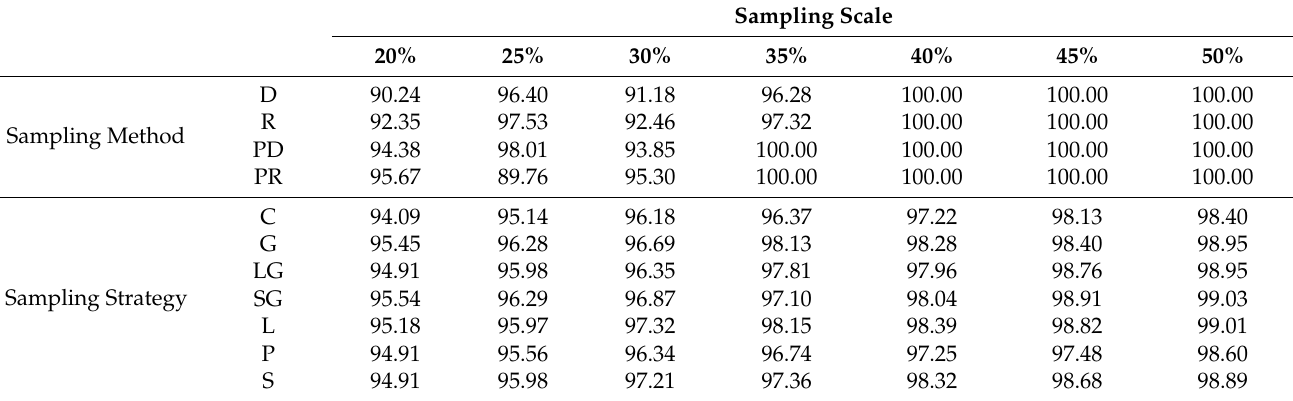
Table 7. Comparison of the range coincidence rates (CR%) of the primary core